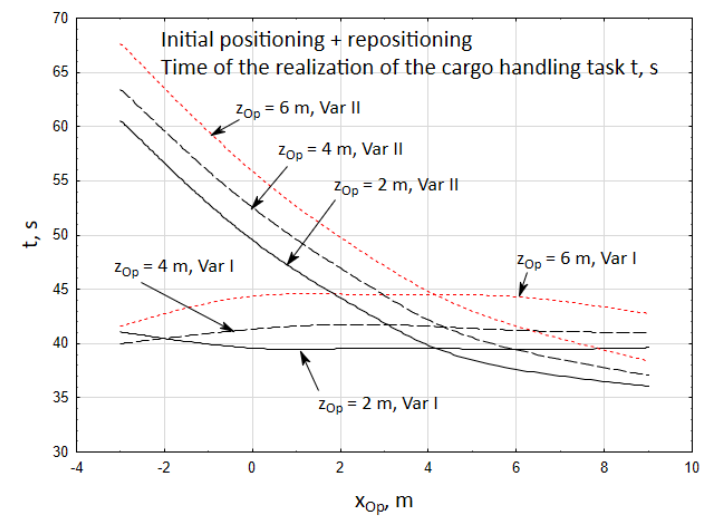
Figure 17. Time of the realization of the cargo handling task t , s .